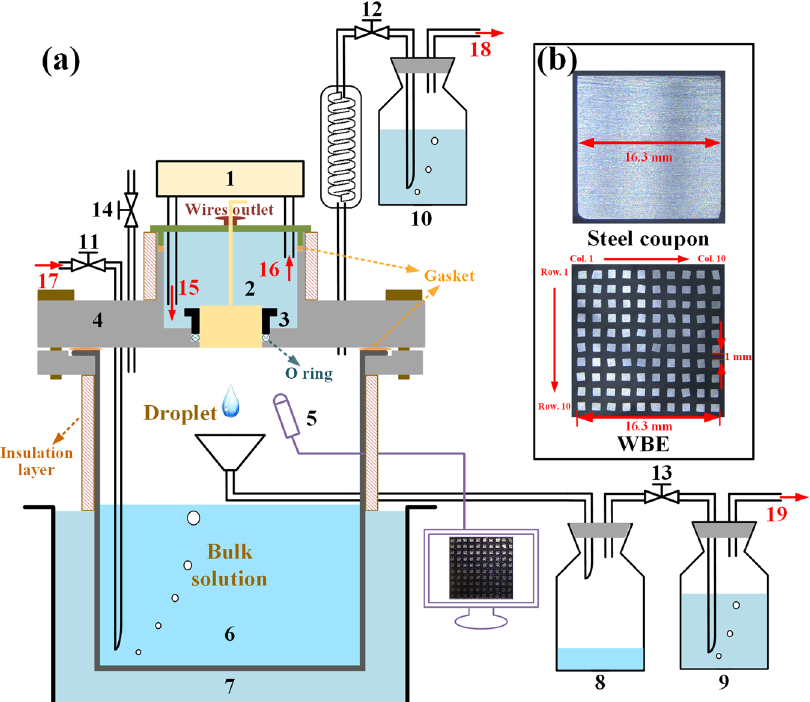
Fig. 12 The test setup used for TLC experiments and the test materials. a The schematic diagram of the TLC simulation system. b The steel coupon and the WBE used in the test. (1 Cooling system, 2 cooling chamber, 3 sample holder, 4 PTFE lid, 5 endoscope, 6 test cell, 7 water